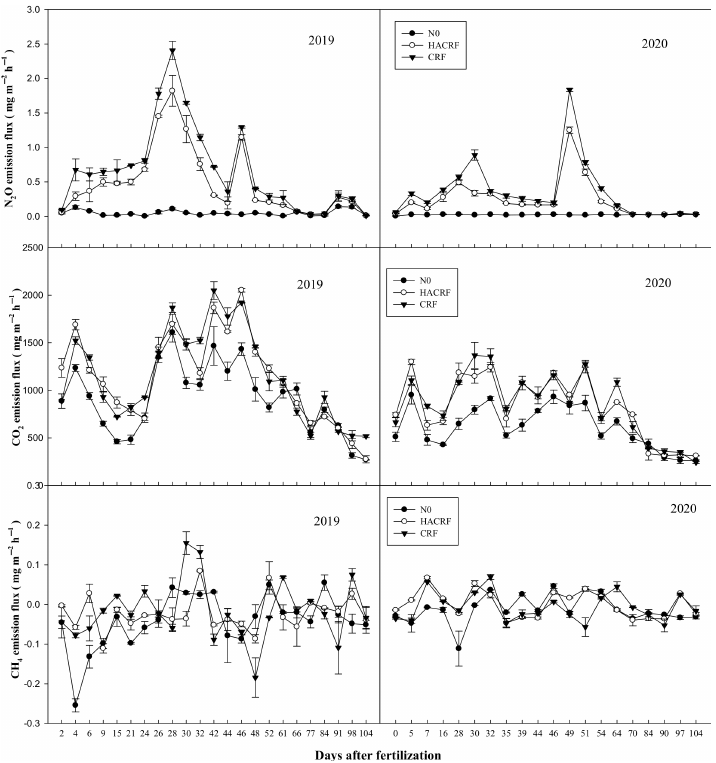
Figure 4. Effects of humic acid added to controlled-release fertilizer on greenhouse gas emission fluxes during summer maize growth in 2019 and 2020. N0: without N fertilizer; CRF: controlled-release fertilizer; HACRF: adding humic acid to controlled-release